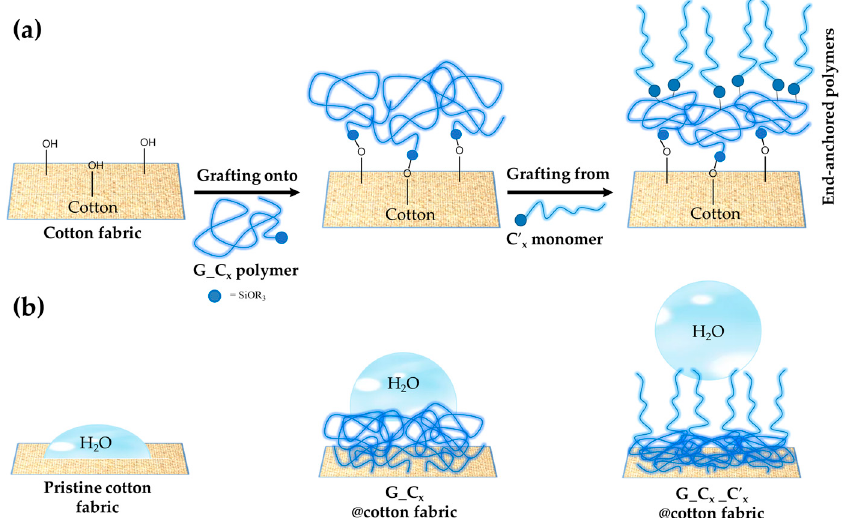
Figure 14. Cotton fabrics are functionalized in two steps with an alkyl(trialkoxy)silane polymer shell using covalent “grafting to” or “grafting from” procedures ( a ). The coated cotton fabrics’ surface hydrophobicity ( b ). Reproduced from MDPI Ref. [67].